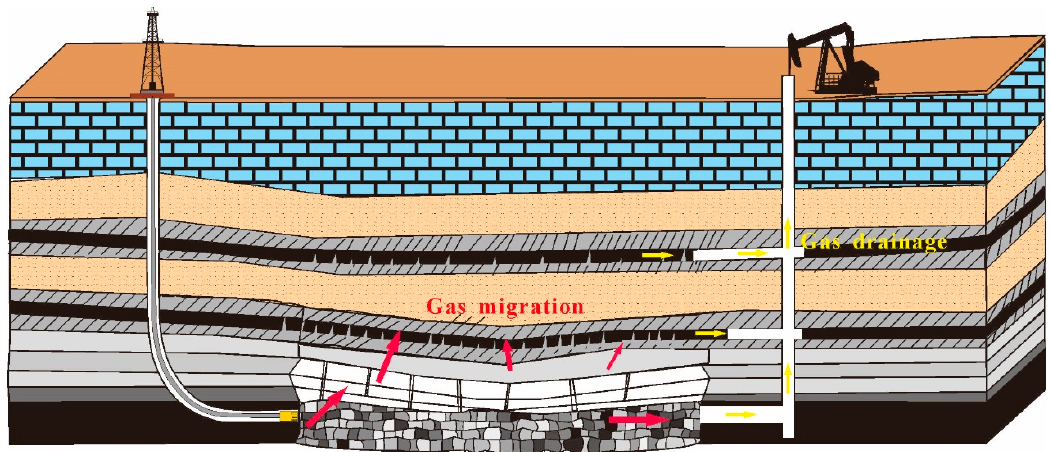
Figure 10. The multiple coal seams commingling production with tectonically deformed coal in-situ CBM recovery by horizontal well cavern completion and stress relief.